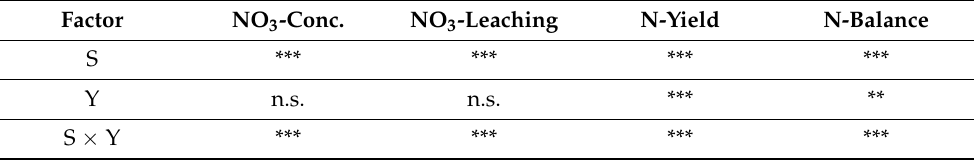
Table 3. Levels of significance among the tested factors: Systems (S), experimental year (Y) and the interaction (S × Y).